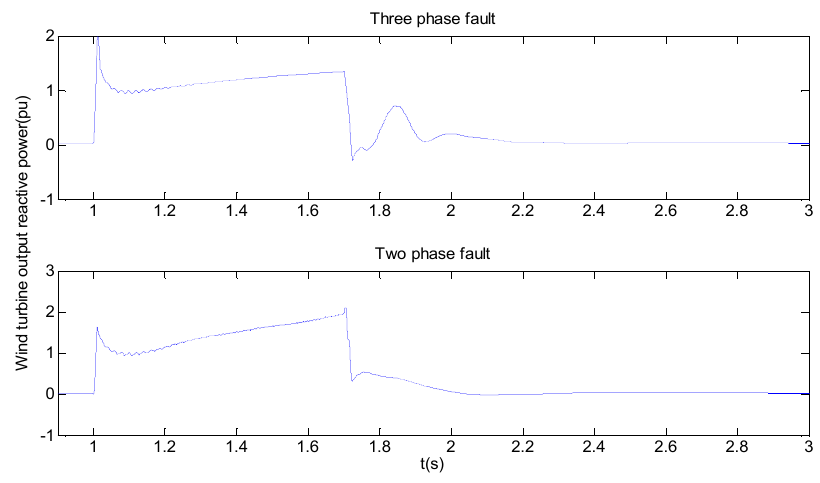
Figure 9. Wind turbine output reactive